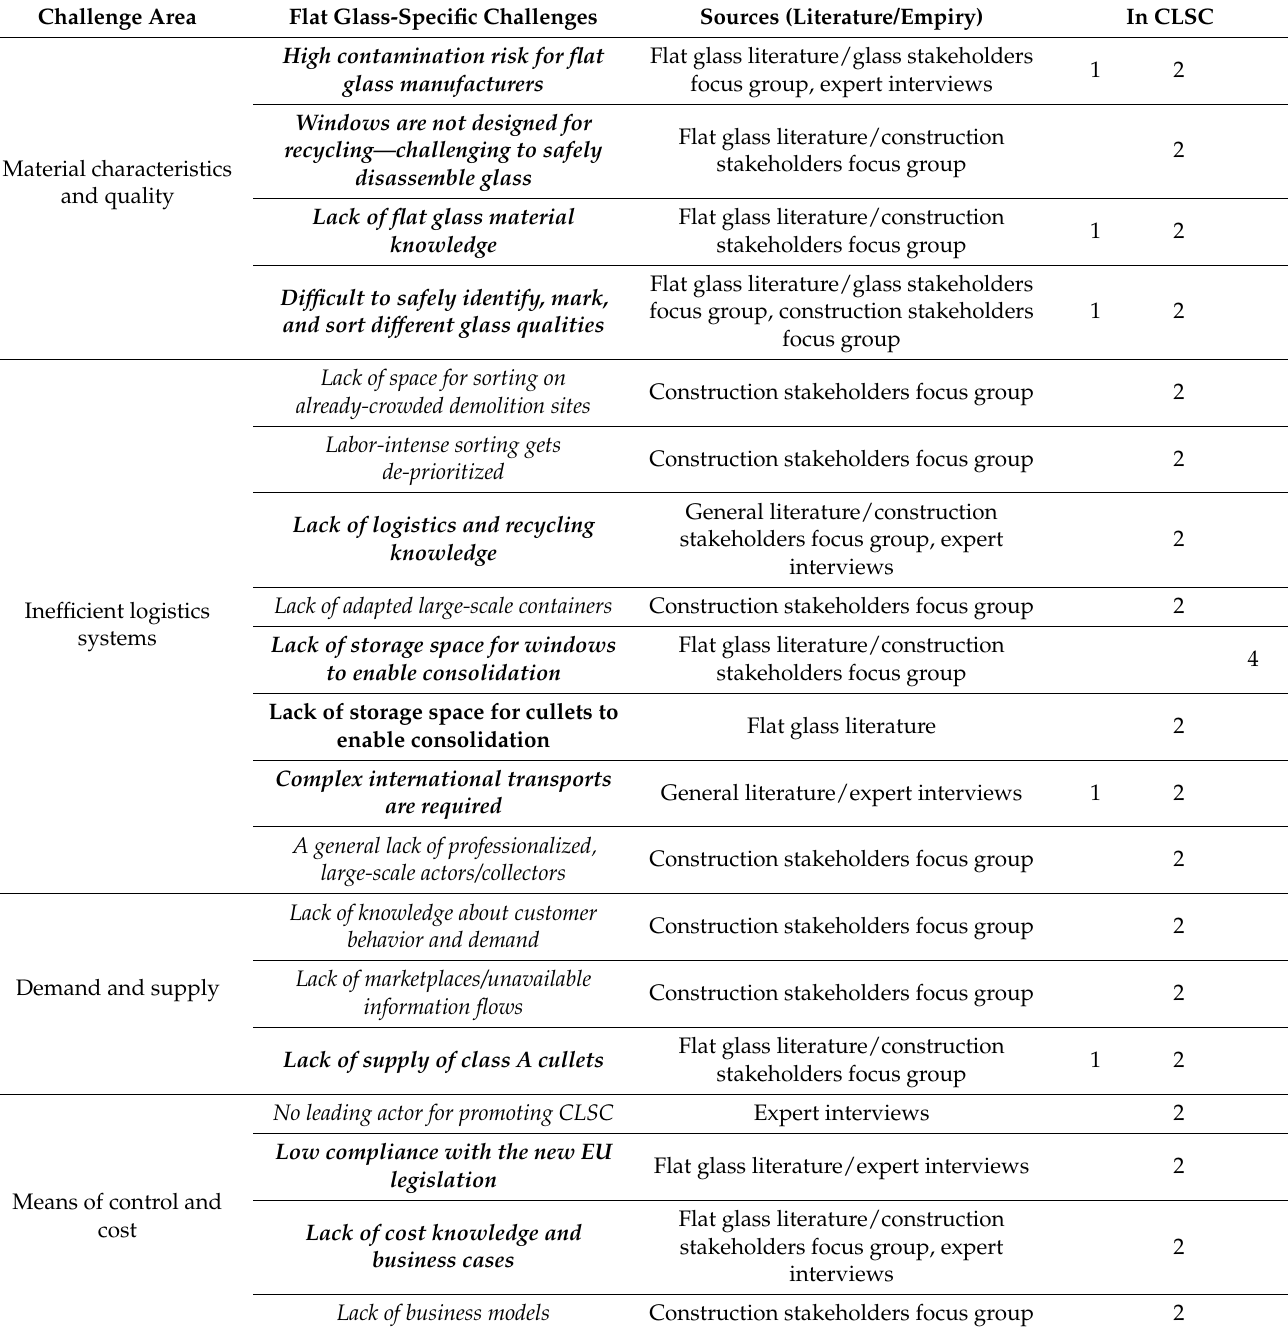
Table 2. A framework for flat glass-specific